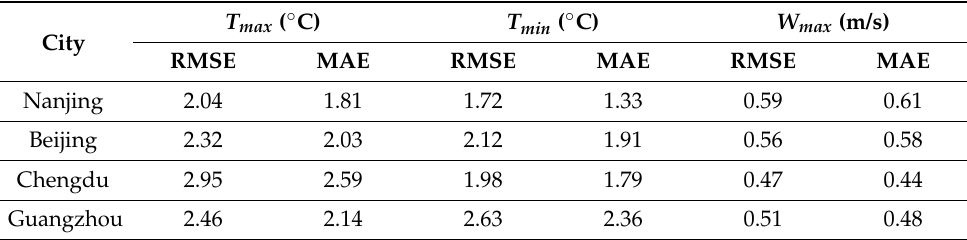
Table 4. The RMSE and MAE values corresponding to Nanjing, Beijing, Chengdu, and Guangzhou (non-holonomic factor